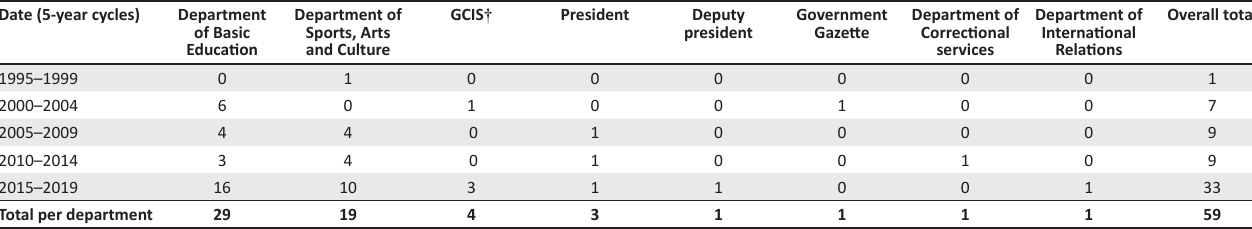
TABLE 1: Tracking individual and departmental references to ‘culture of reading’ (1990–2019). Date (5-year